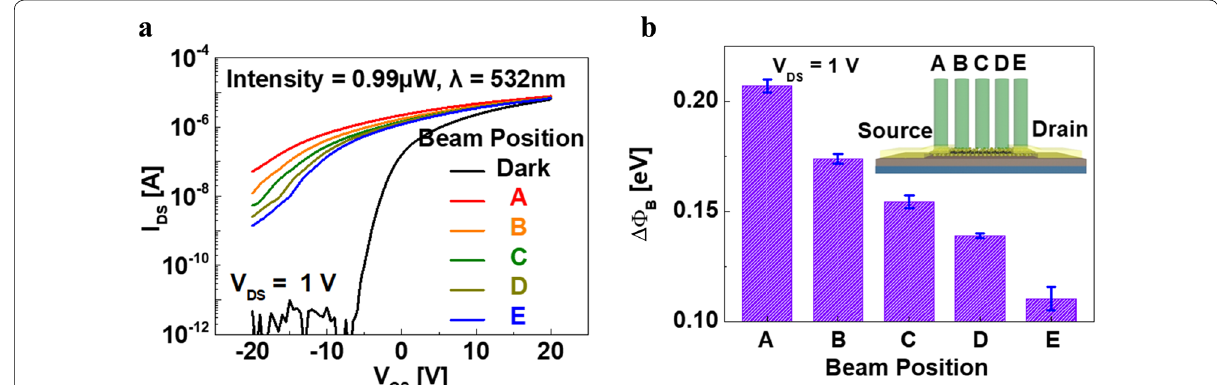
Fig. 5 a I DS –V GS curves and b variations in the barrier height with the beam position of the multi-layer MoS 2 phototransistors (Inset: 3D schematic image of a MoS 2 phototransistor representing the different beam